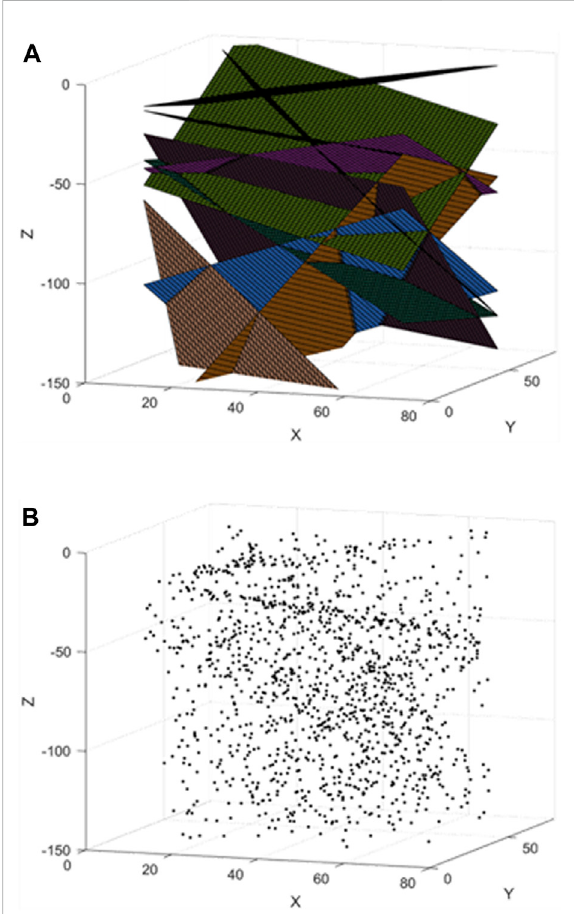
FIGURE 9 Synthetic experiments to verify the suitability of the GARNET algorithm for location data including outliers. (A) True model consisting of 10 fracture planes, (B) 100 randomly distributed points from each fracture plane with high ratios of location errors and 500 outlier points independent of the microseismic